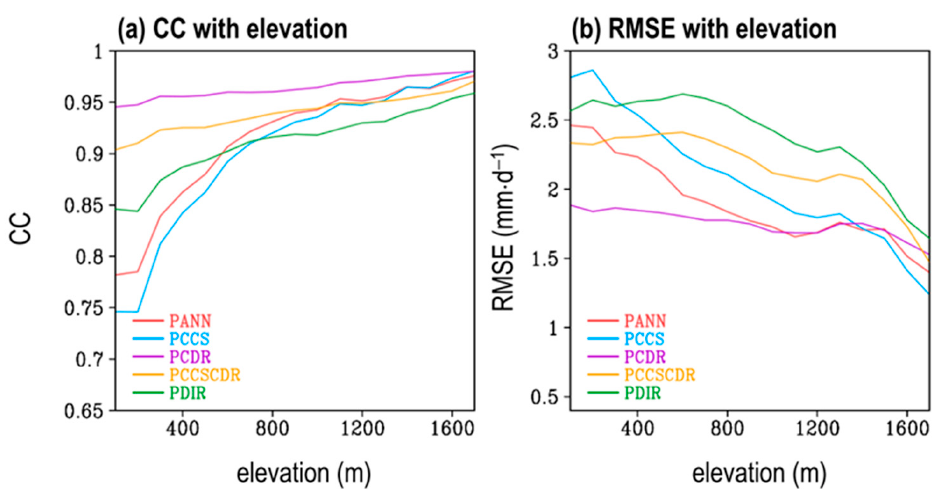
Figure 6. ( a ) The CC of Figure 5a area-averaged at different elevations; and ( b ) the RMSE of Figure 5b